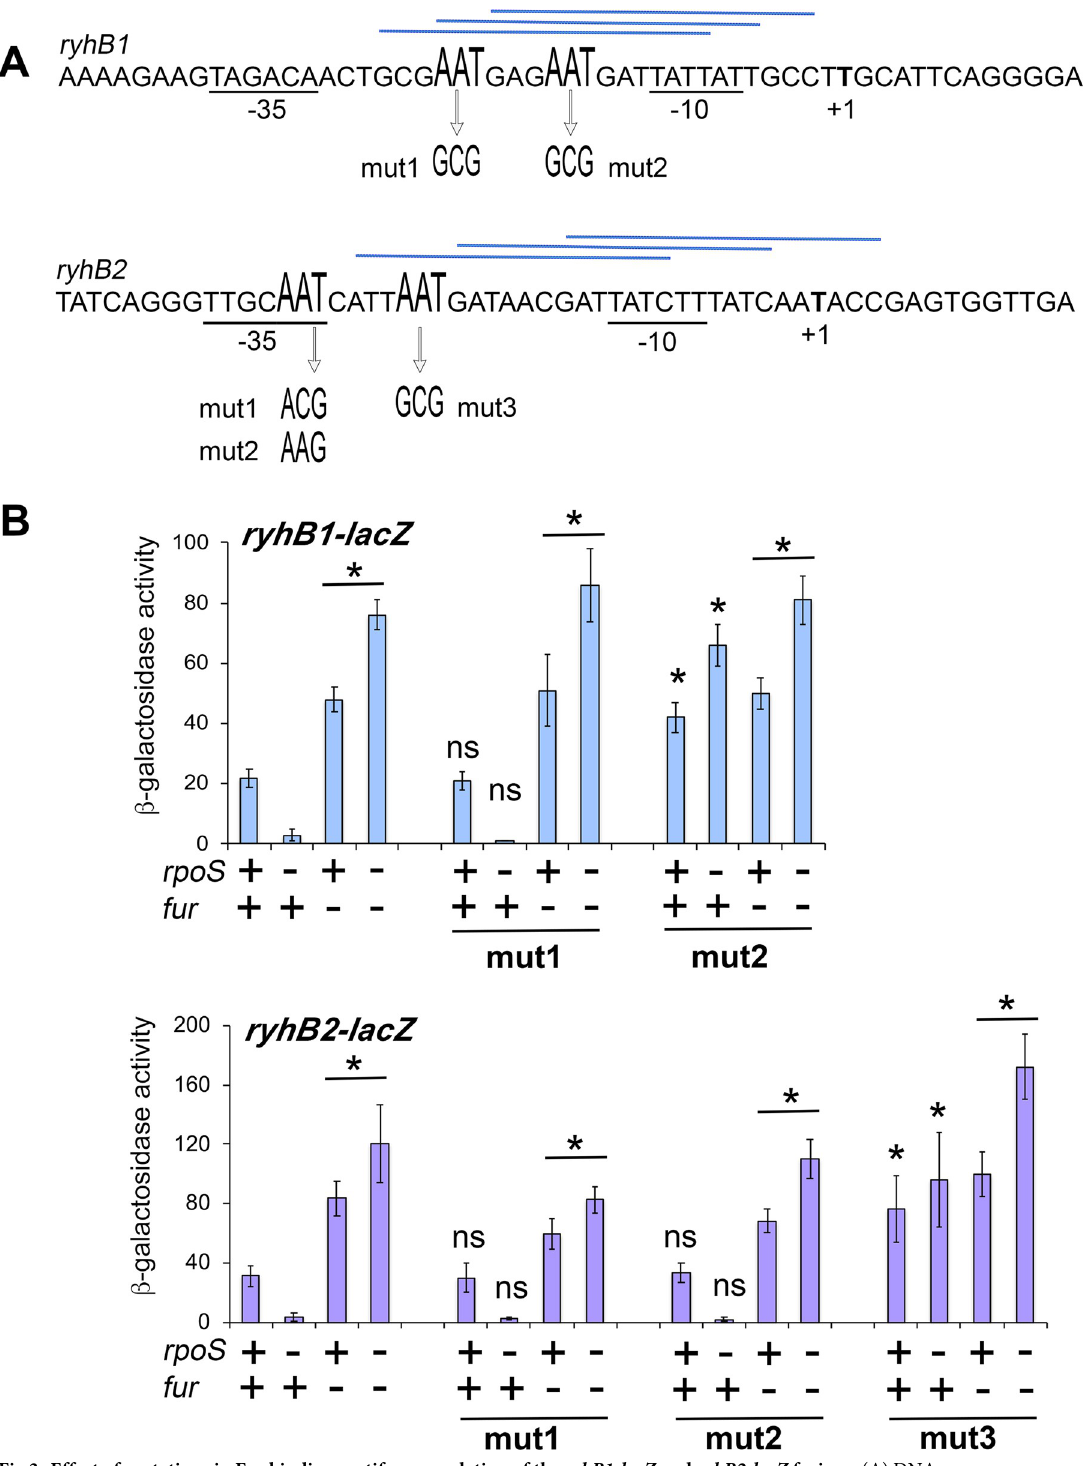
Fig 3. Effect of mutations in Fur binding motifs on regulation of the ryhB1-lacZ and ryhB2-lacZ fusions. (A) DNA sequences corresponding to the 5’ end and upstream regions of the ryhB1 and ryhB2 sRNAs genes are shown. The -10 and -35 promoter regions are underlined. The possible Fur binding sites that match the Fur consensus sequence (gataatgataatcattatc) are indicated by blue lines above the sequences of ryhB1 and ryhB2 [14]. Mutations constructed in AAT motifs are shown (see text for details). (B) Expression of the chromosomal ryhB1-lacZ and ryhB2-lacZ fusions carrying or not the indicated mutations was assessed in Salmonella wild type, Δ rpoS ,